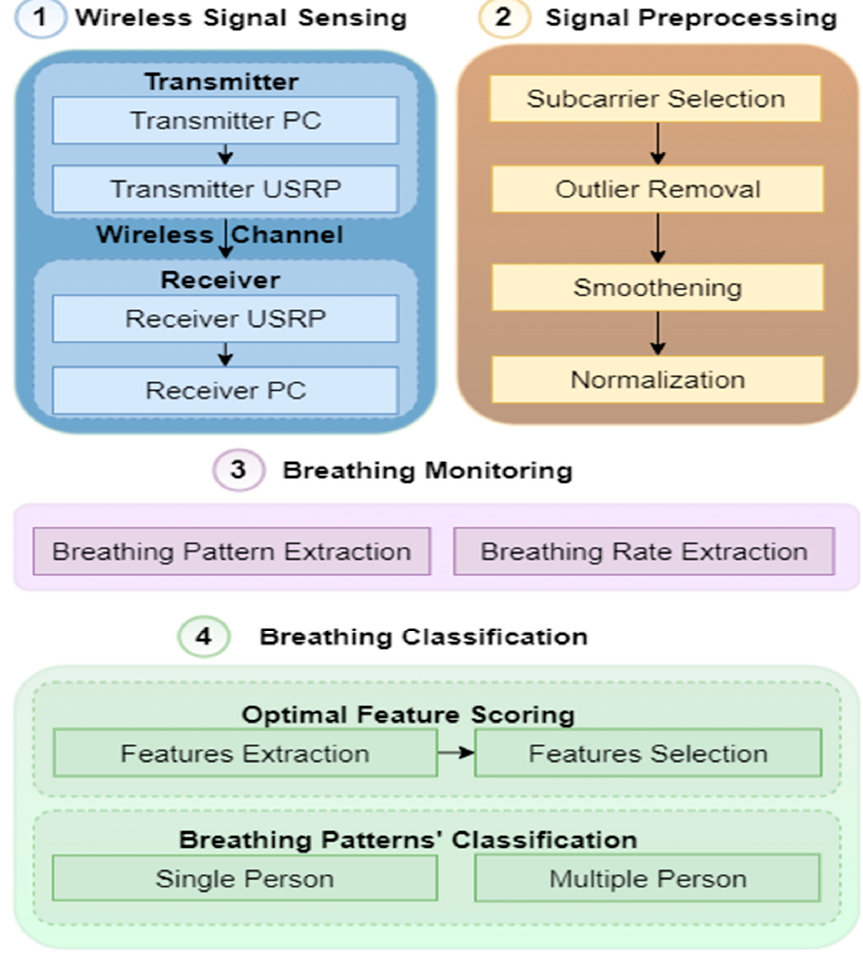
Figure 1. Design methodology.